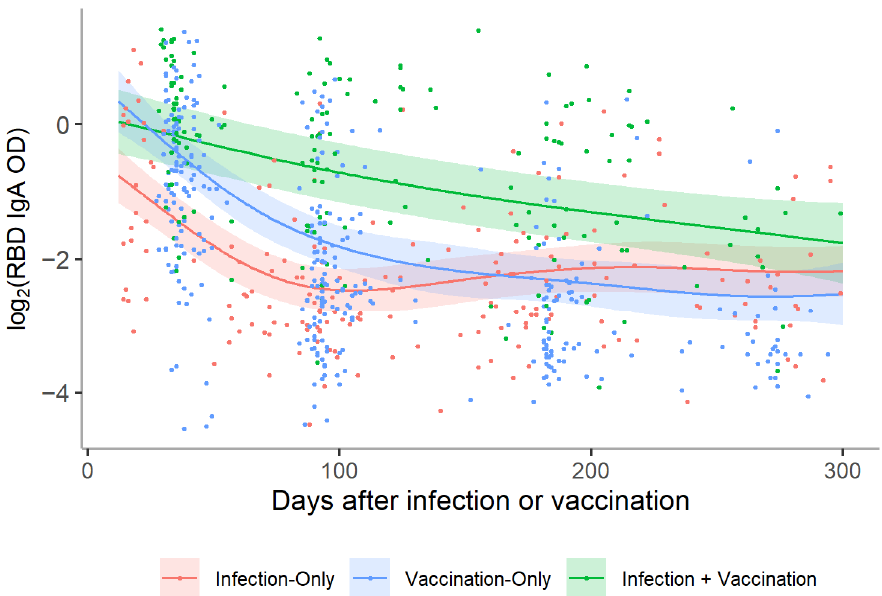
Figure 4. Log 2 anti-RBD IgA titers over time for participants in the infection-only, vaccination-only, and infection + vaccination groups. A distinct smoothing function was fit for samples from the infection-only ( n = 201), vaccination-only ( n = 346), and infection + vaccination ( n = 162) groups using a GAM. The figure represents the mean trajectory for each group marginalized over age and sex. A random intercept was also included to account for repeated measures within individuals. The two vaccine groups displayed higher titers soon after infection/vaccination compared with the infection-only group; however, the vaccination-only group displayed a similar trajectory to the infection-only group: a more rapid decline in the first 100 days and becoming more stable thereafter. Conversely, the infection + vaccination group displayed a more gradual decline before approaching the levels of the other two groups approximately 300 days post-infection/vaccination.